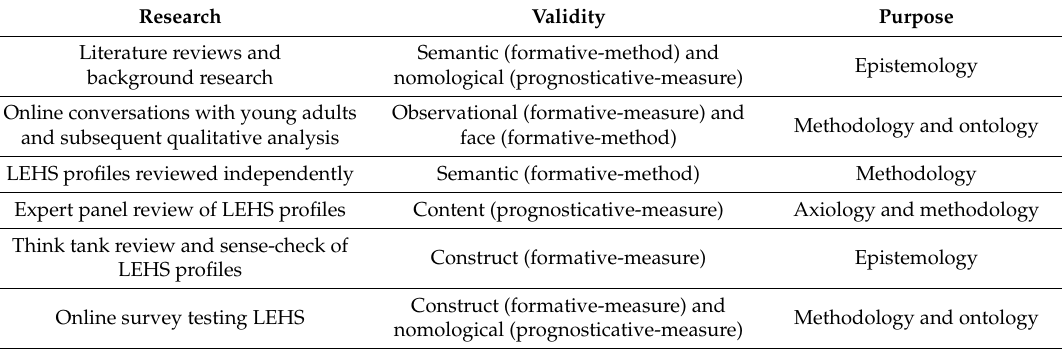
Table 1. Types of validity and formative research stages in LEHS profile